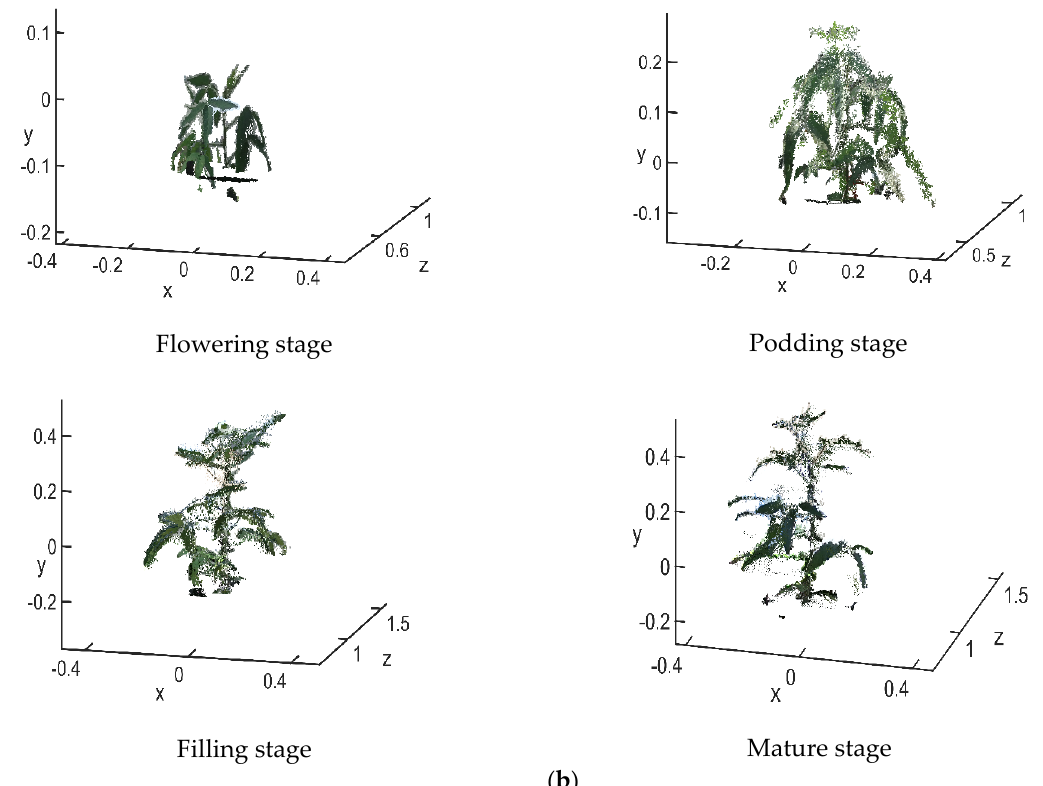
Figure 14. Point cloud registration ( a ) before registration ( b ) after reconstruction.